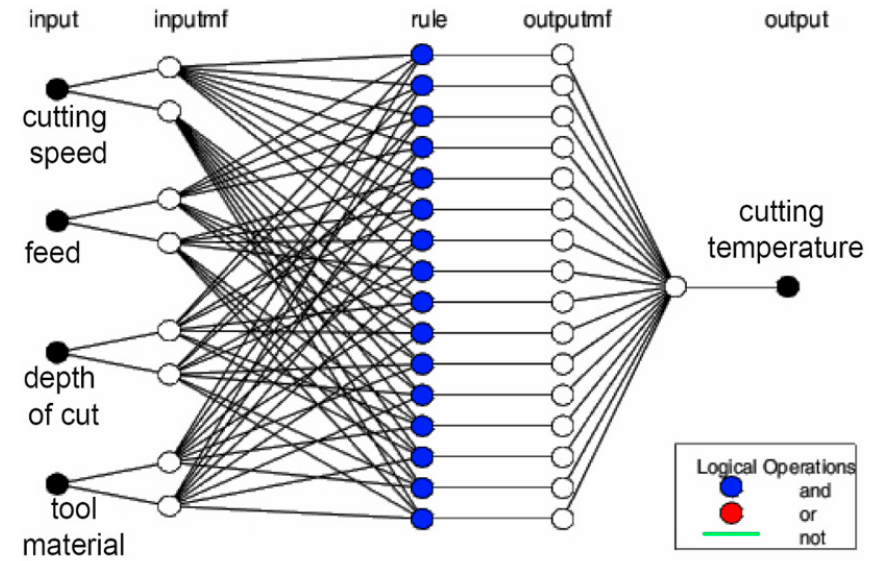
Figure 3. Adaptive fuzzy inference system.